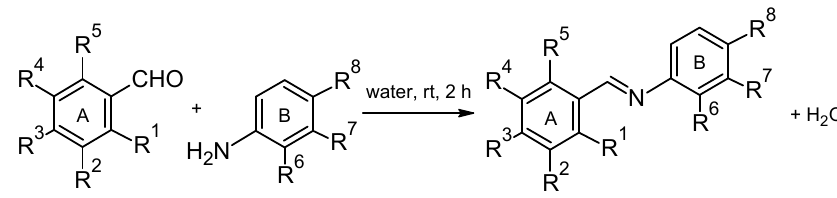
Scheme 1. Preparation of iminophenol analogs of resveratrol.